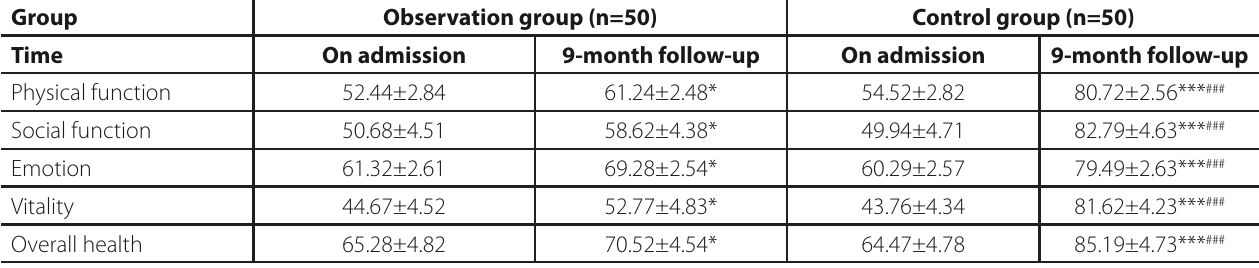
Table 3. Comparison of QOL between the two groups before and after continuing care.